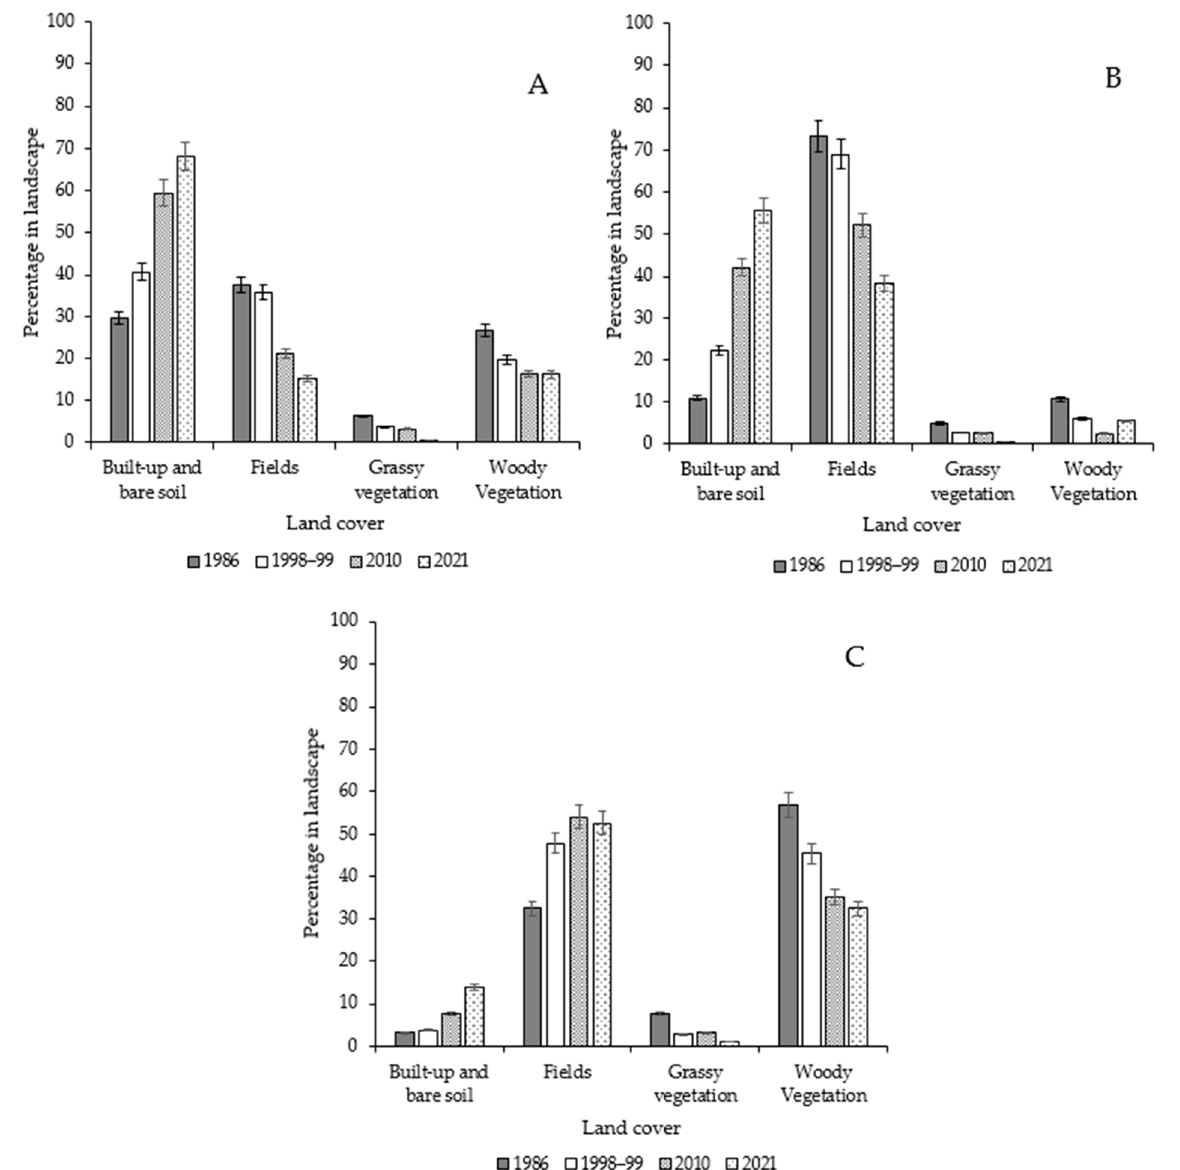
Figure 4. Evolution of the percentage of landscape of different land cover types in municipalities with urban ( A ), peri-urban ( B ) and rural ( C ) zones morphological status. These results were obtained on the basis of supervised classification of Landsat image mosaics from 1986, 1998–1999, 2010 and 2021 based on the maximum likelihood algorithm. The vertical bars represent the standard deviation.